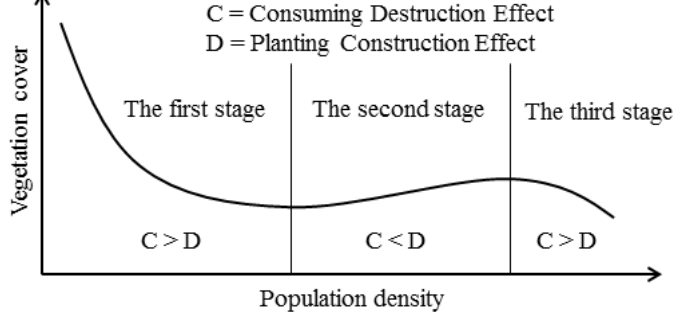
Figure 4. The long-term inverted N-shaped curve relationship between population growth and vegetation cover.